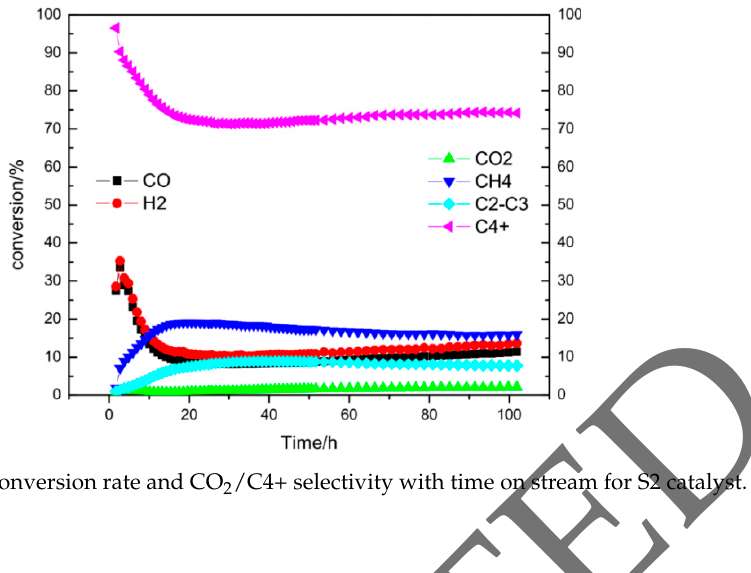
Figure 10. CO conversion rate and CO 2 /C4+ selectivity with time on stream for S2 catalyst.